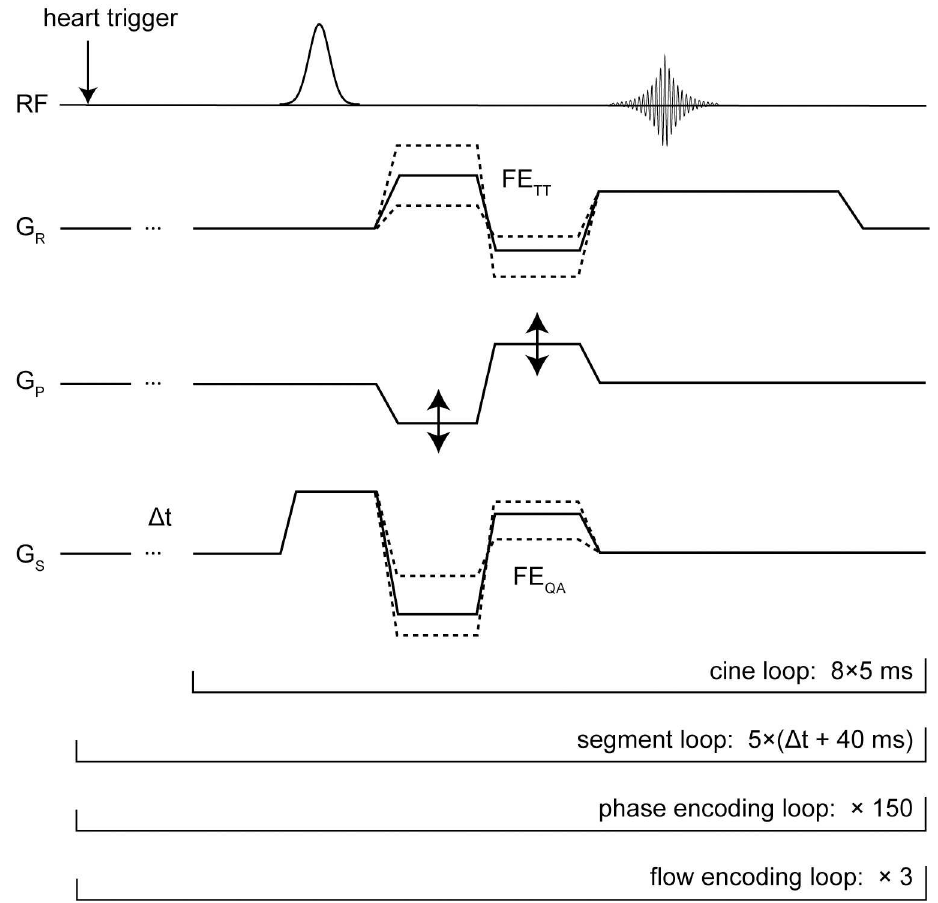
Fig 1. Phase-Contrast-Cine pulse sequence. Phase-Contrast-Cinepulse sequenceto measure globaland local pulse wave velocities(PWV). The sequencewas repeatedfive times (segment loop) starting with a variabledelay Δ t = (0ms, 1ms, 2ms, 3ms, 4ms) thus yieldingto an effective temporalresolutionof 1000 frames per second. Further abbreviations: RF: radio frequencytransmission;G P : phase encoding gradient; G R : frequencyencodinggradient; G S : slice encoding gradient; FE QA : axial flow encodingfor the local PWV measurement; FE TT : 1D in-planeflow encodingfor the globalPWV